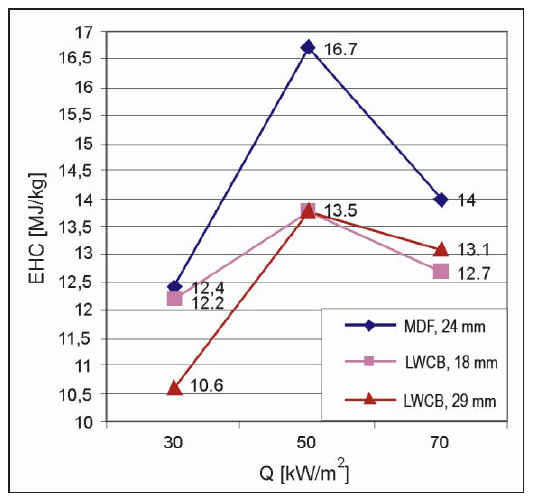
Fig. 12. Mean values of the total heat released (THR) when exposed to the surface heat flow of 30, 50 and 70 kW/m 2 densi- ty for different tested boards